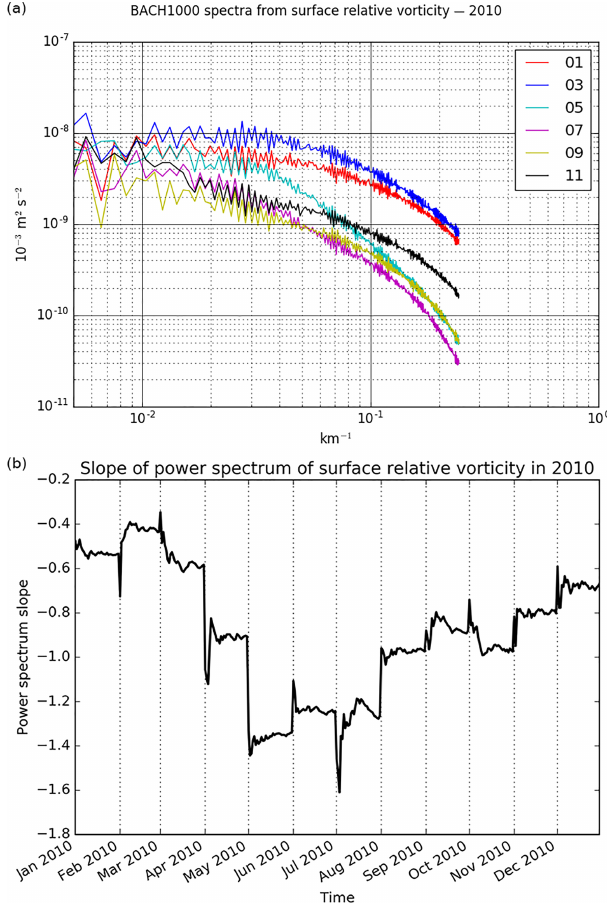
Figure 11. Power spectrum (computed for each latitude and aver- aged over longitudes and time during the considered month) from surface relative vorticity for the year 2010 (a) . Numbers in the leg- end correspond to the months in the year 2010. Time series of the regressed spectral slope from the power spectrum of surface relative vorticity in 2010 (b) . Spectral slopes have been computed consider- ing wavelengths from 7 to